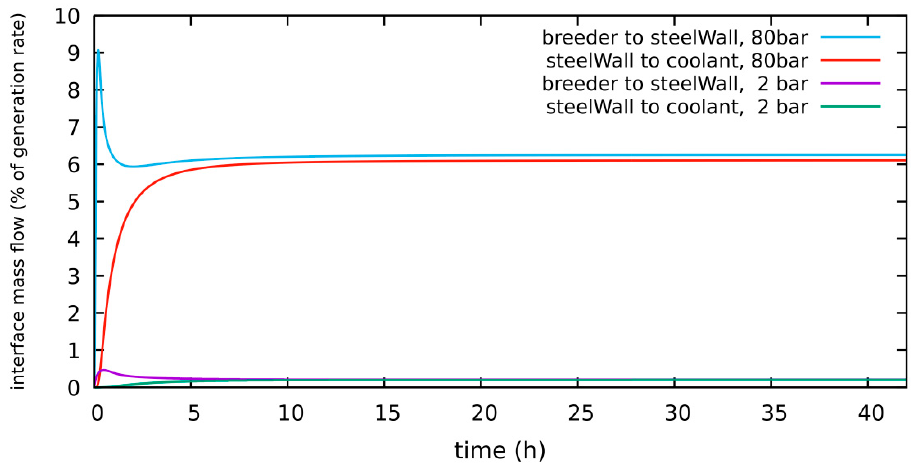
Figure 22. Transient tritium flow through patch interfaces breeder to and from steel, and steel to and from coolant for 2-bar vs. 80-bar purge gas pressure at equal mass flow.